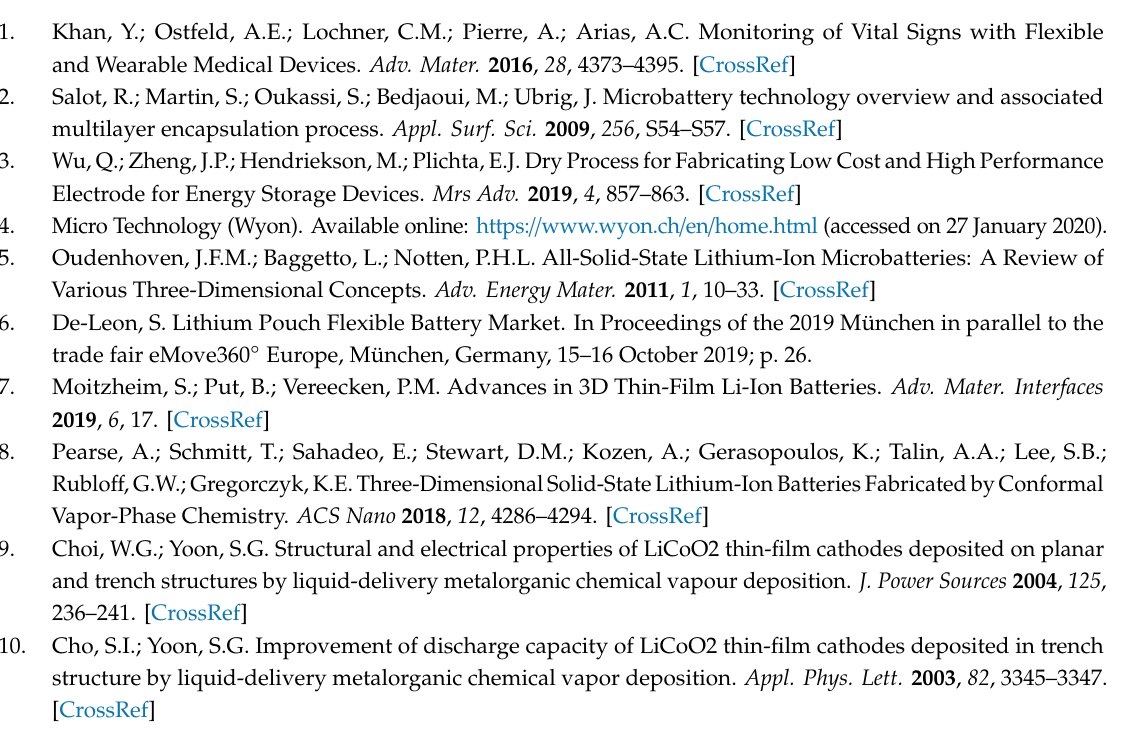
Figure S1. Plan-view SEM images of the surface of the samples LNO-1 / 10, LNO-1 / 3, LNO-1 / 2, LNO-1 / 1. Figure S2. Plan-view (a) and cross-sectional (b) SEM images of sample LNO-1 / 3. Figure S3. X-ray photoelectron (XPS) N1s (a) and Ni2p (b) spectra of LNO samples. Figure S4. Grazing incidence XRD of as-deposited NO-1), LNO-1 / 10-2), and LNO-1 / 3-3). Figure S5. X-ray reflectometry (XRR) curve of LNO-1 / 3. Figure S6. X-ray reflectometry (XRR) curve of LNO-1 / 10. Figure S7. X-ray reflectometry (XRR) curve of LNO-M. Figure. S8. Time-of-flight secondary-ion-mass spectroscopy (TOF-SIMS) depth profiles of the negative ions of LNO-M. Figure S9. X-ray photoelectron spectroscopy depth profiles of the LNO-M-800. Figure S10. Time-of-flight secondary-ion-mass spectroscopy (TOF-SIMS) depth profiles of the LNO-M-800 (a) positive ions, (b) negative ions. Figure S11. X-ray photoelectron (XPS) Si2p spectra of LNO-M—(a), Si2p spectra of LNO-M-800—(b), Fe2p spectra of LNO-M-800—(c), Cr2p spectra of LNO-M-800—(d). Figure S12. SEM images of lamella preparation. Figure S13. Energy-dispersive X-ray spectroscopy (EDX) spectra obtained in point 1 and 2 marked in Figure 11a. Table S1. Results of X-ray photoelectron (XPS) depth profiling of LNO-M. Table S2. Results of X-ray photoelectron spectroscopy (XPS)